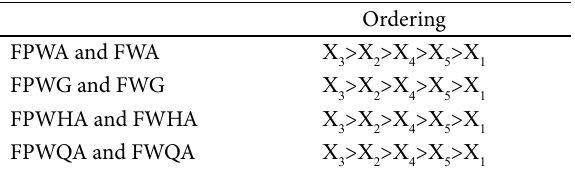
Table 15. Ordering of the alternatives